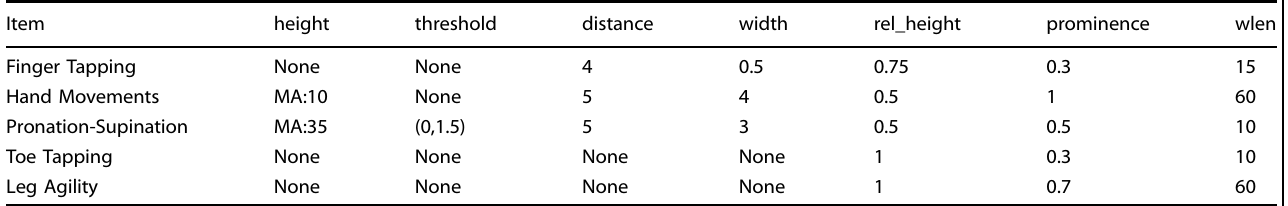
Table 8. Features extracted from the time-series signals (see Table 6). Feature